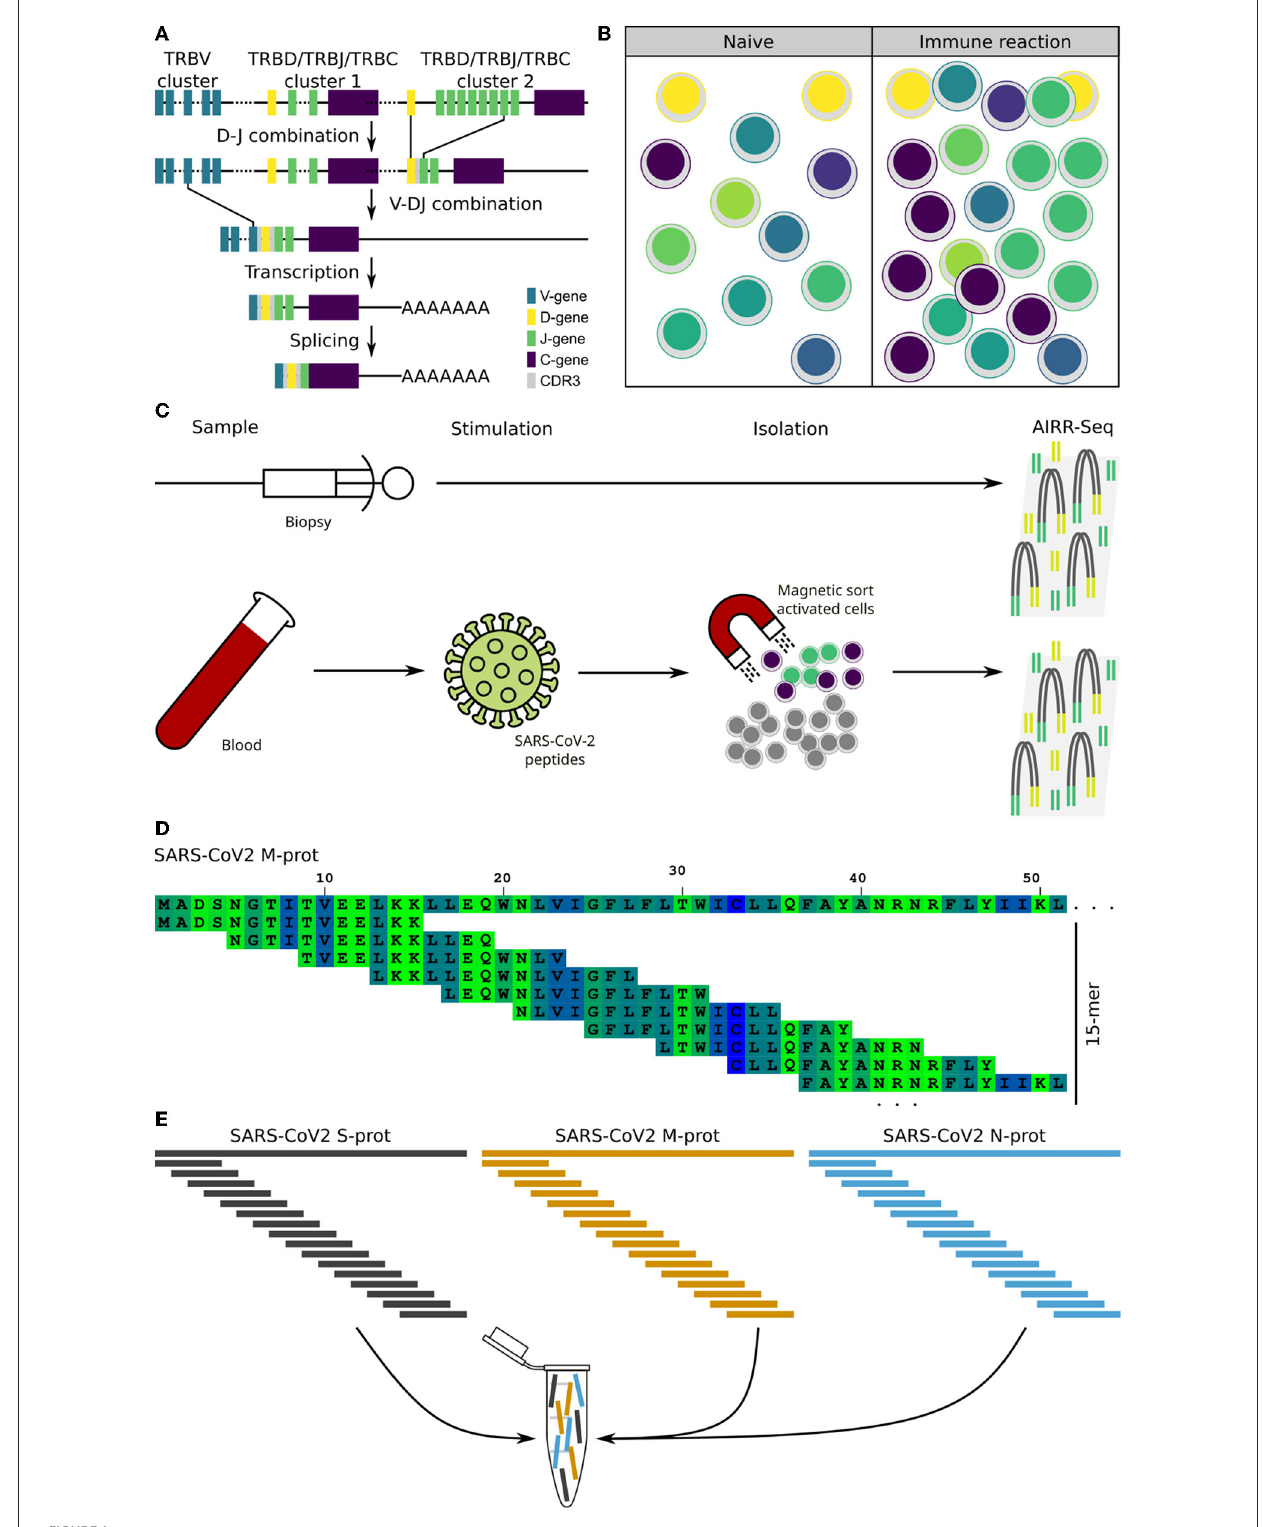
FIGURE1 Background and assay. Theoretical background of the T cells receptor (TCR) as a cellular fingerprint, and the process of extracting the data for evaluation. (A) Schematic representation of the V-D-J recombination of the TCR beta locus together with the creation of the CDR3 segment, which constitutes a cellular fingerprint. (B) Clonal expansion of antigen specific T cells during an immune reaction. (C) Schematic representation of the experimental assay to obtain TCR sequences for comparison and evaluation. (D) Principle of 15-mers with a 11-mer overlap. The first 50 amino acids of the SARS-CoV-2 M-protein is used as example sequence. (E) Overlapping peptides from the three proteins are pooled into a single peptide pool used for T cell